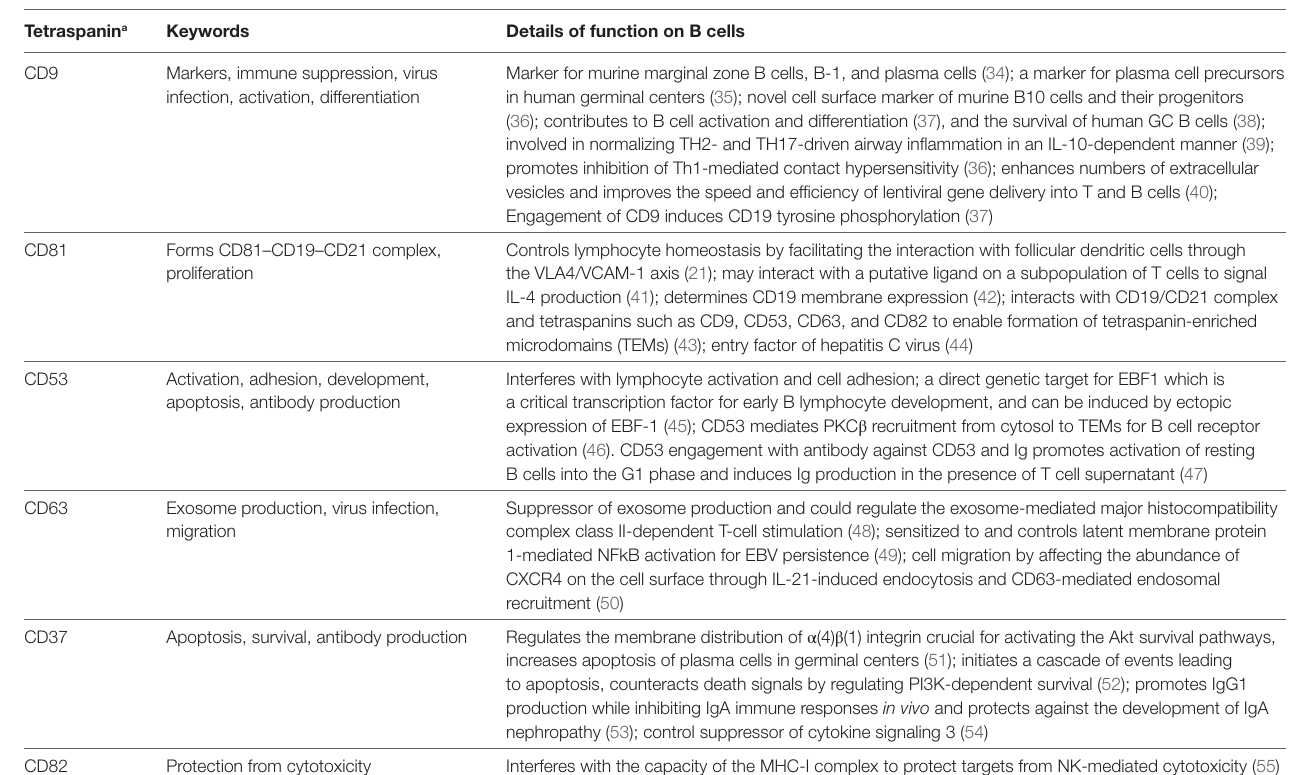
TABLe 3 | Function of tetraspanin on B